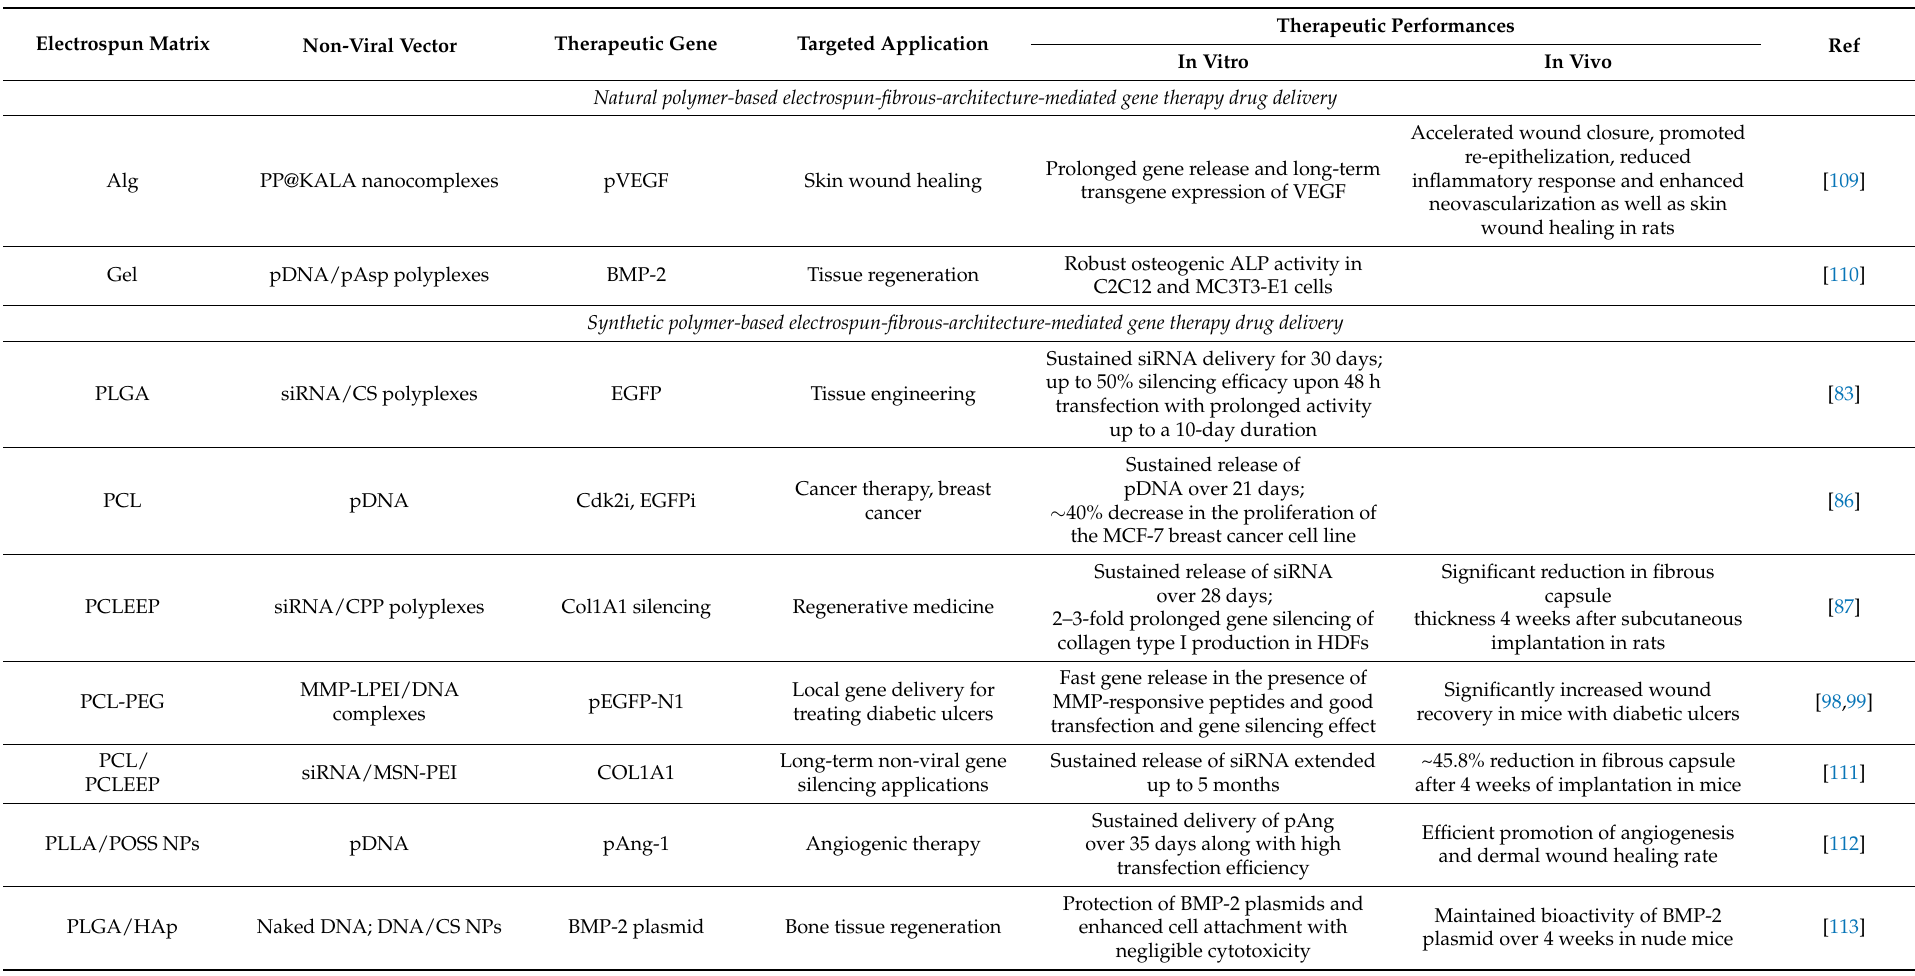
Table 4. Representative electrospun-fibrous-architecture-mediated gene therapy drug delivery along with the targeted application and biological